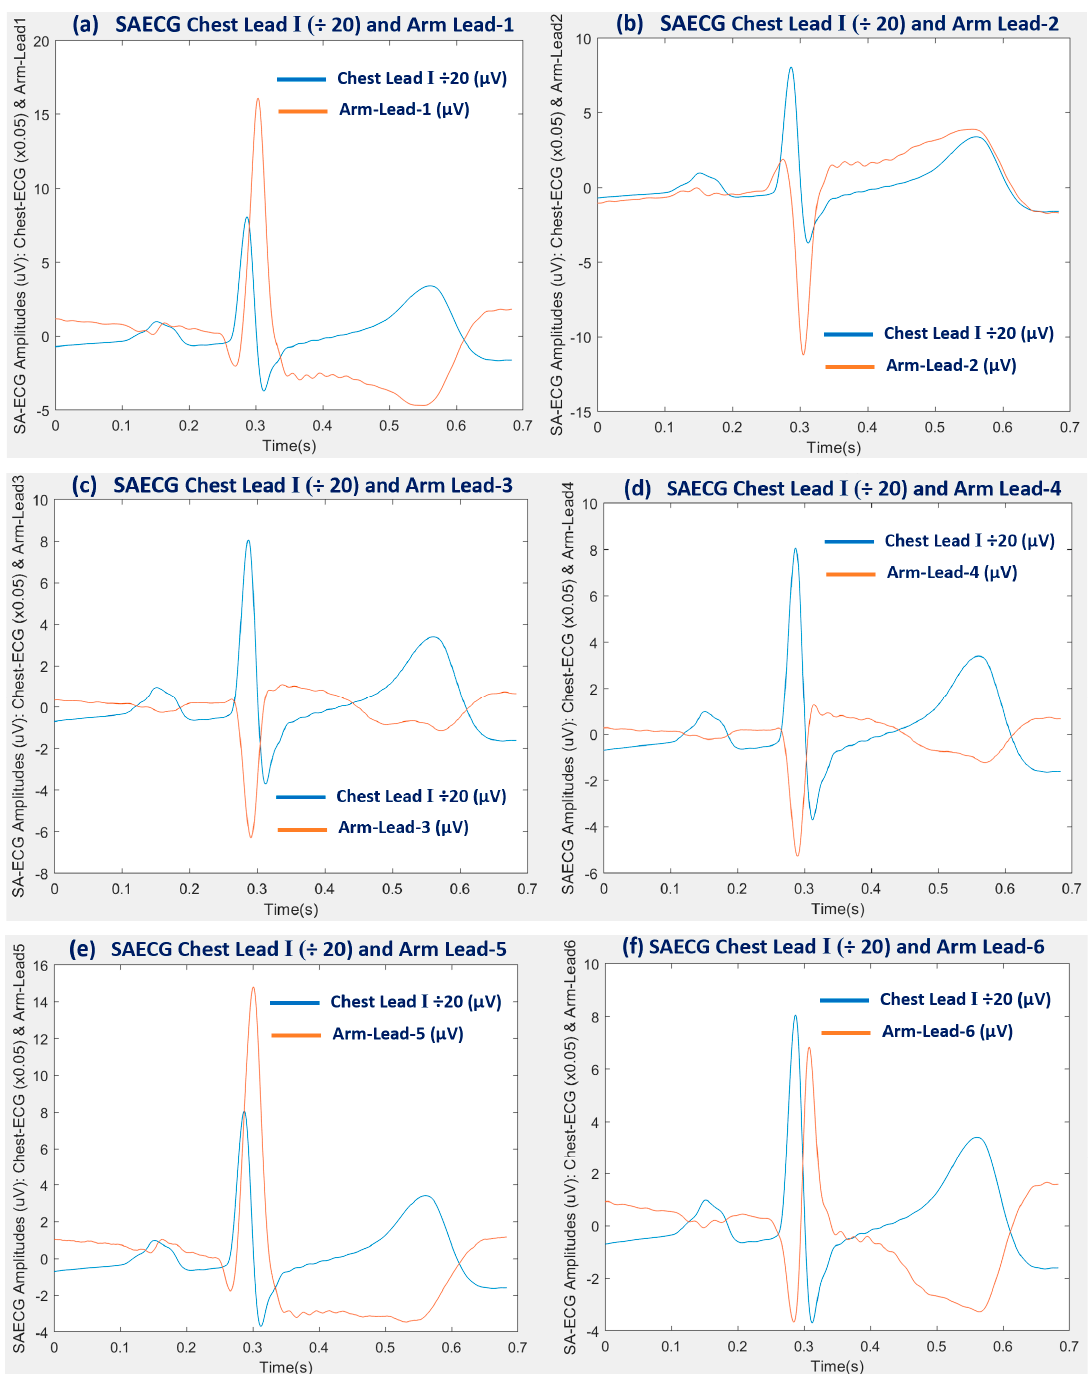
Figure 3. Example subject case results of signal averaged ECG denoising process P-QRS-T frames (700s), of reference Chest Lead I ECG signal (blue) and bipolar arm-ECG signals (brown) for the six arm leads (Lead-1 to Lead-6) under study, after averaging 564 validated heart beats. Table 3. Statistics summary of EDQ metrics: ECG event signal ratio metrics (QRS SNR, PqrsR%, TqrsR%), results summary on the SAECG of the six bipolar arm-leads and on the reference Chest- Lead, over the 18 subject cases, after outliers removal.